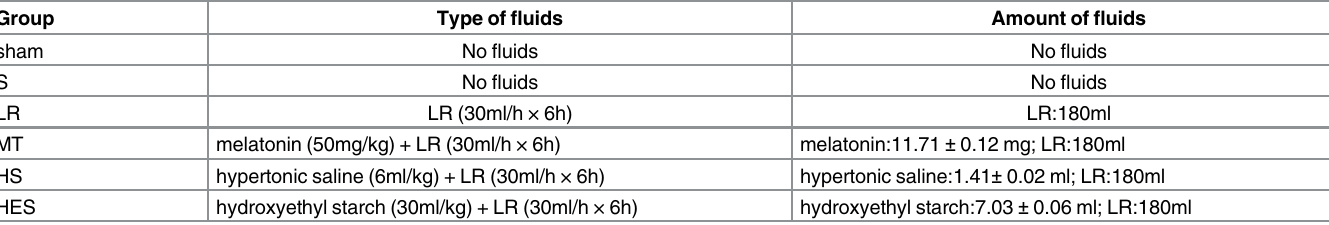
The rats were randomly divided into 6 groups. In the sham group and the Shock group (S group, n = 8), rats were given no fl uids. Animals subjected to resuscitation were treated with lactated Ringer solution (LR group,30 mL/h × 6hr), melatonin plus LR (MT group, 50mg/kg), 7.5% hypertonic saline plus LR (HS group, 6ml/kg), or hydroxyethyl starch 130/0.4 plus LR(HES group, 30ml/kg). Data of the amount of fl uids are presented as means ± S.E.M., n = 8 in each